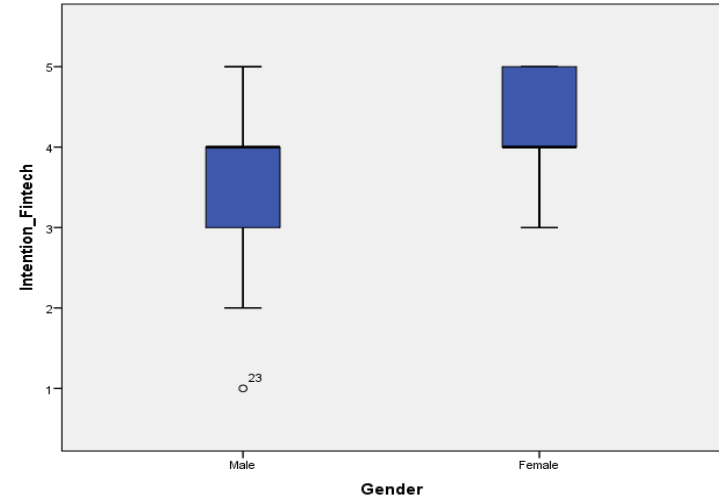
Figure 4. Boxplot of gender and fintech intention. Table 11. Mean and Standard Deviation of Research Variables.